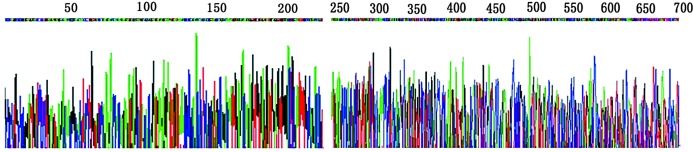
Sequence of the pGEM-T-MHBst167 by direct sequencing.